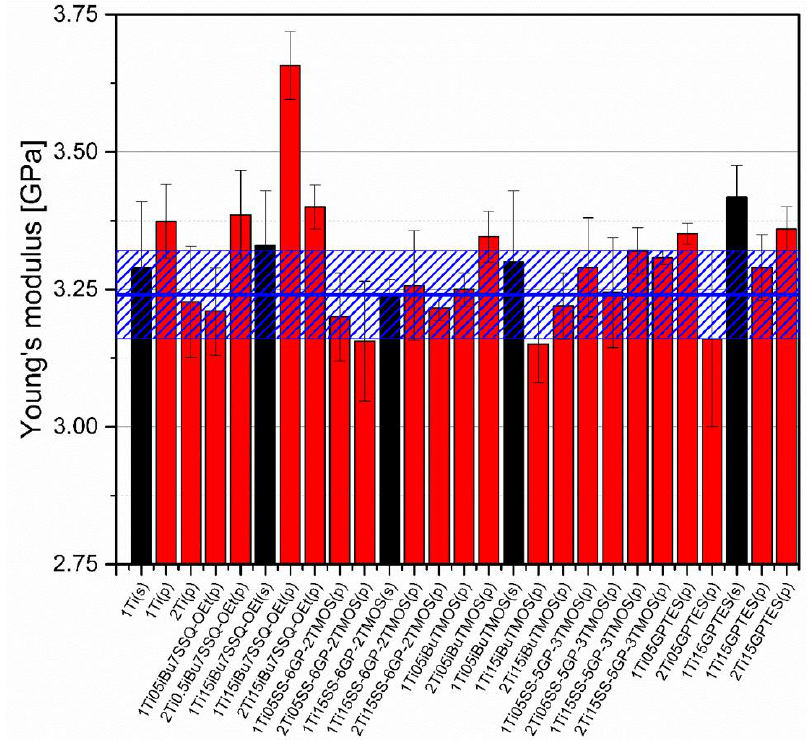
Figure 14. Young’s modulus of neat and modified TiO 2 /EP composites.